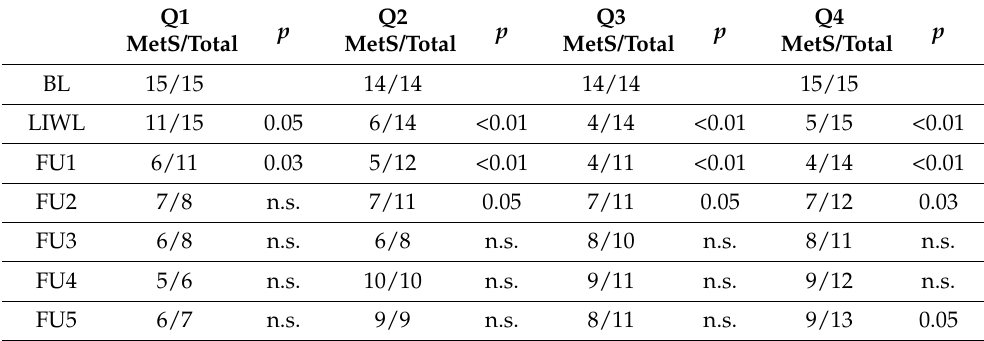
Table 8. Table showing the absolute numbers of participants with metabolic syndrome (MetS) and the total number of participants at the indicated timepoints in each quartile (Q1–Q4). Q1 Q2 p